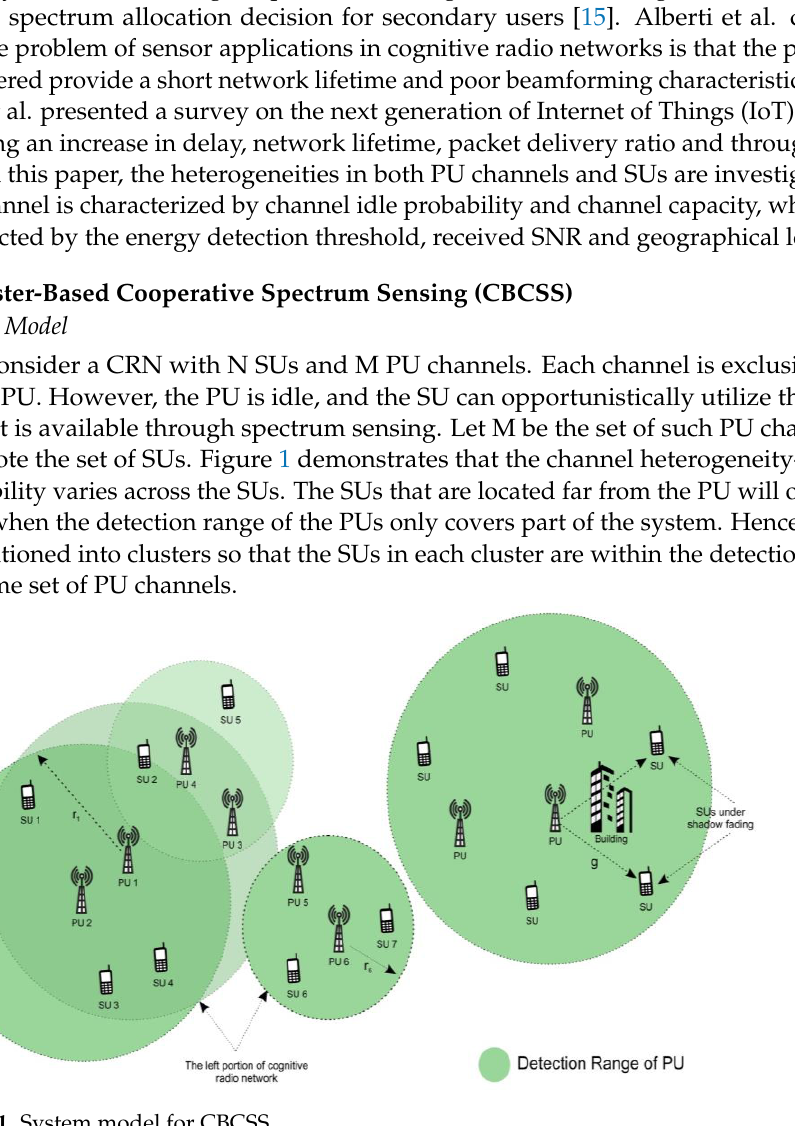
Figure 1. System model for CBCSS .